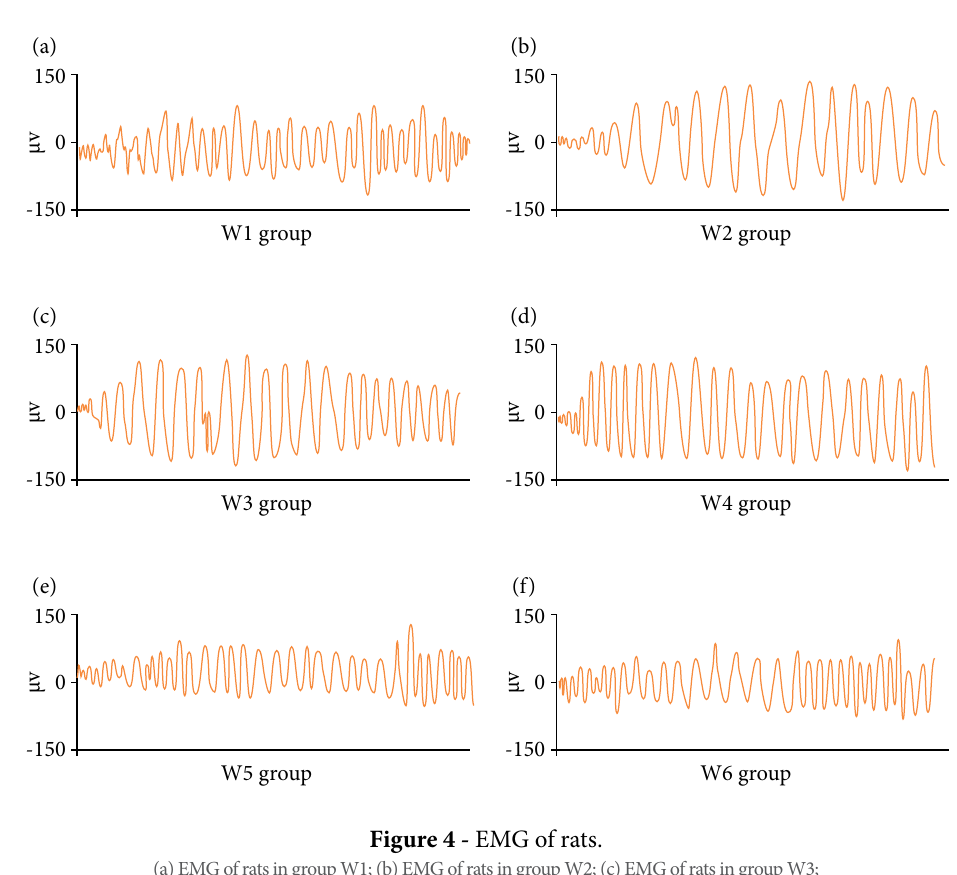
Figure 4 - EMG of rats.